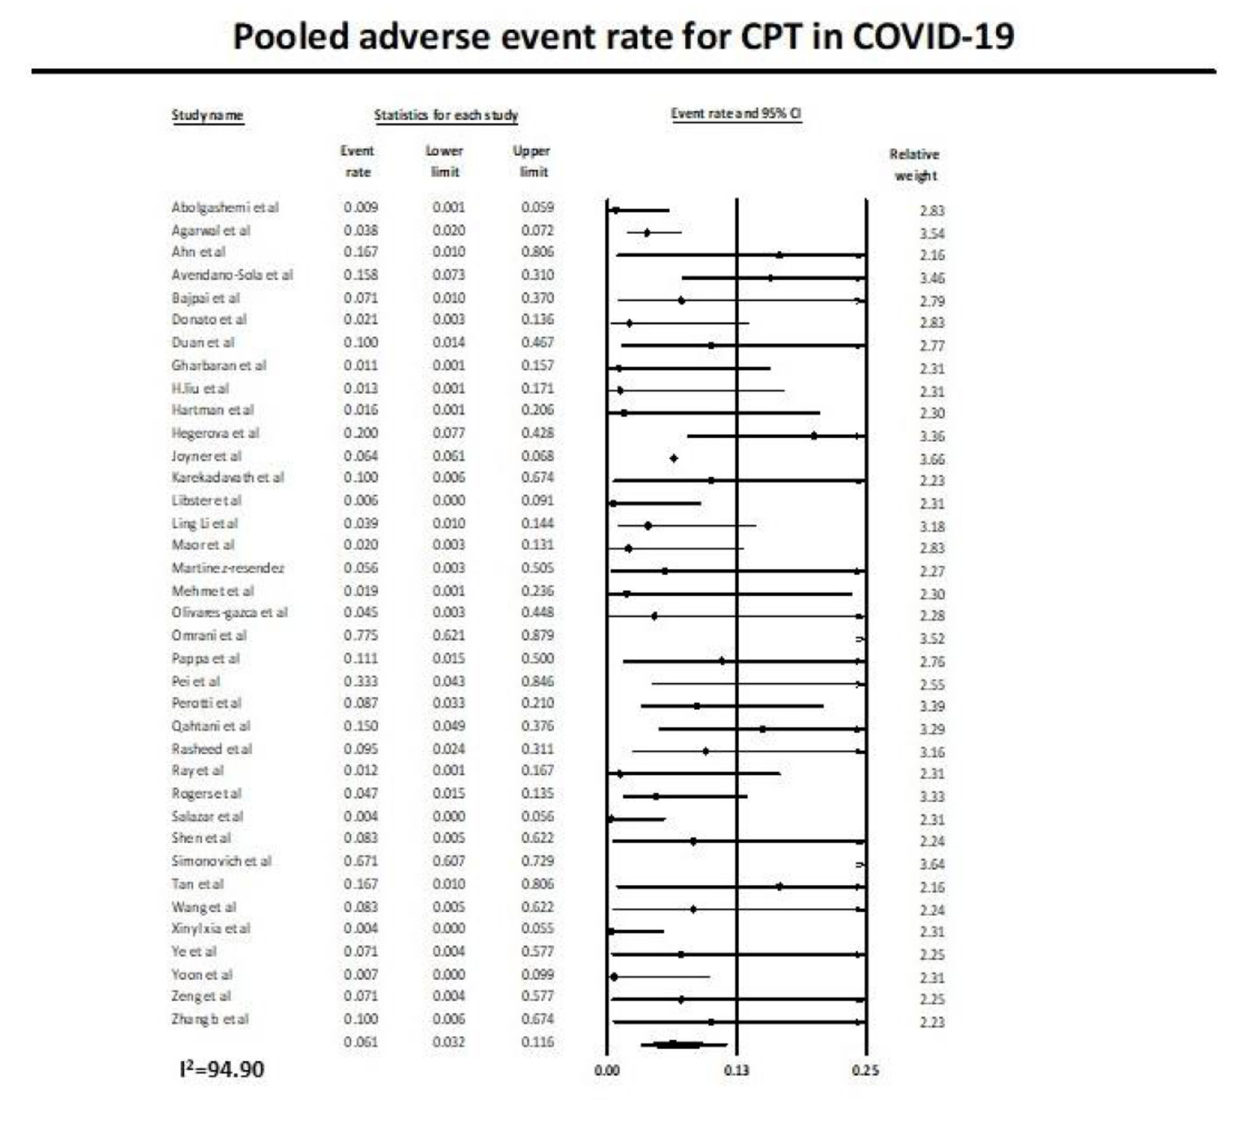
FIGURE 4 | Pooled adverse event rate with use of CPT in